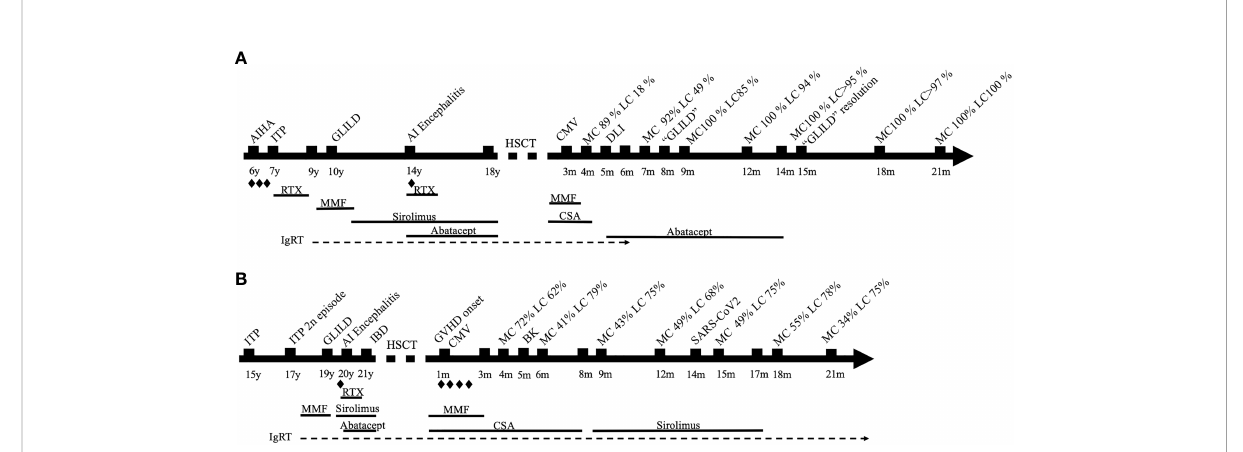
FIGURE 1 (A) Timeline of case 1. (B) Timeline of case 2. Steroids; AIHA, autoimmune hemolytic anemia; ITP, immune thrombocytopenic purpura; AI, autoimmune; HSCT, hematopoietic stem cell transplantation; CMV, cytomegalovirus; MC, myeloid chimerism; LC, lymphoid chimerism; CSA, cyclosporin; DLI, donor lymphocyte infusion; GLILD, granulomatous-lymphocytic interstitial lung disease; RTX, rituximab; IgRT, immunoglobulin replacement therapy; IBD, in fl ammatory bowel disease; GVHD, graft-versus-host